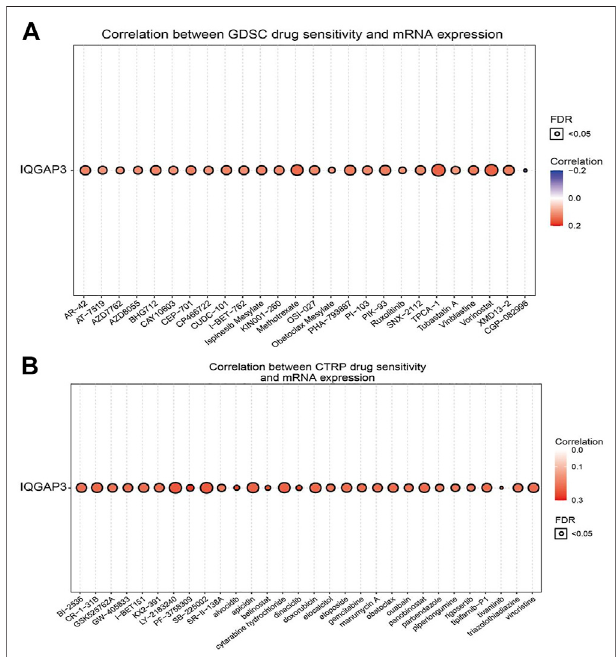
FIGURE12| AnalysisofthecorrelationbetweentheIQGAP3expression anddrugsensitivityindiversehumancancers. (A) Thecorrelationbetweenthe IQGAP3 expression and drug sensitivity in diverse human cancer analyses was performed by employing the GDSC database. (B) The correlation betweentheIQGAP3expression and drugsensitivity indiversehumancancer analyses was performed by employing the CTRP database.